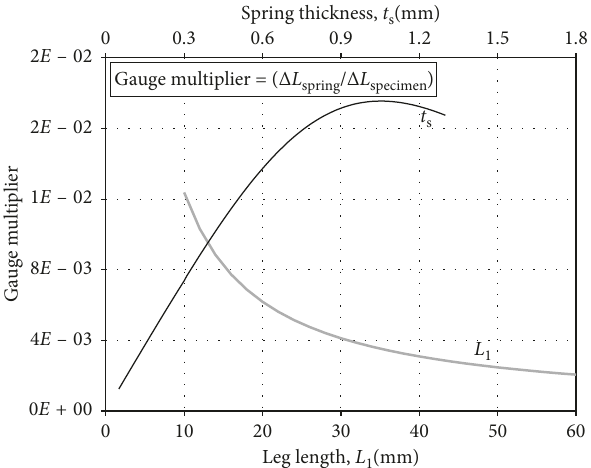
Figure 5: Influence of SDG geometry on its